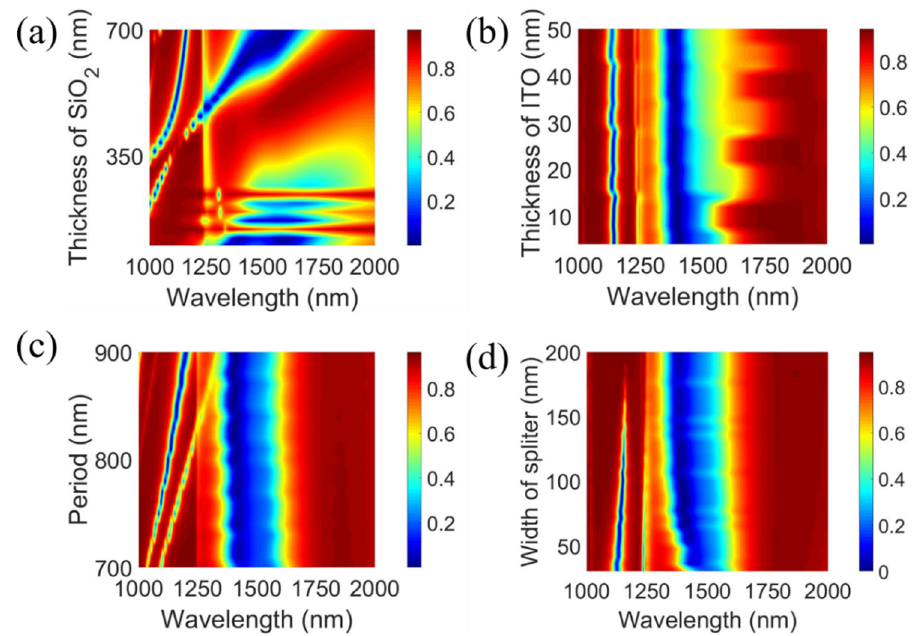
Figure 2. Reflectivity for the different thicknesses of ( a ) SiO 2 and ( b ) indium tin oxide (ITO), ( c ) period, and ( d ) width of the splitter.